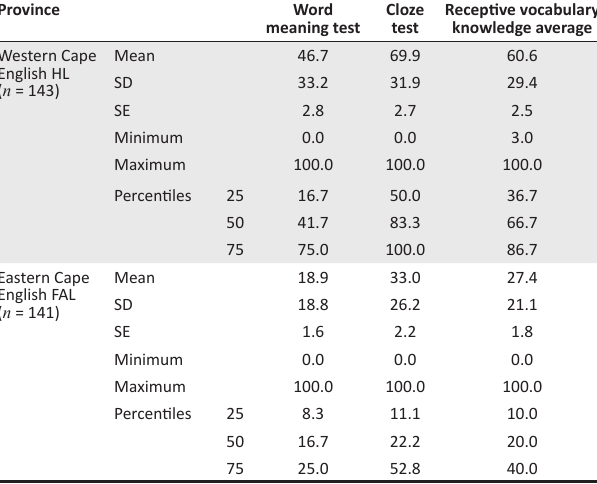
TABLE 6: Receptive knowledge of high-frequency words per province ( % ).